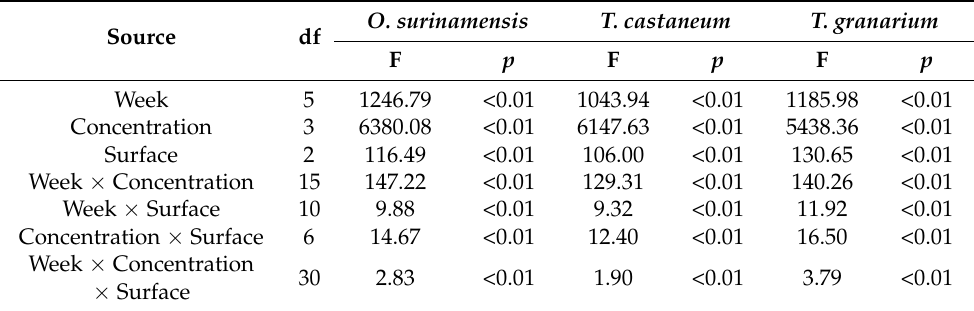
Table 1. ANOVA for main effects and interactions for adult emergence of Oryzaephilus surinamensis , Tribolium castaneum , and Trogoderma granarium (Error df: 216). O. surinamensis T. castaneum T. Source df